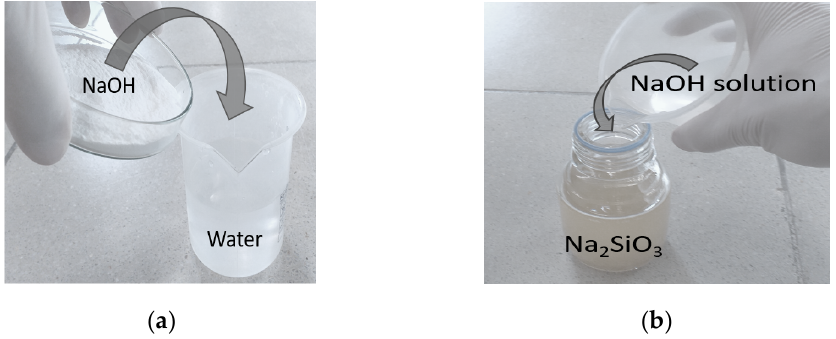
Figure 1. Preparation of alkaline activator: ( a ) sodium hydroxide (NaOH) solution; ( b ) combination of sodium hydroxide (NaOH) and sodium silicate (Na 2 SiO 3 ).